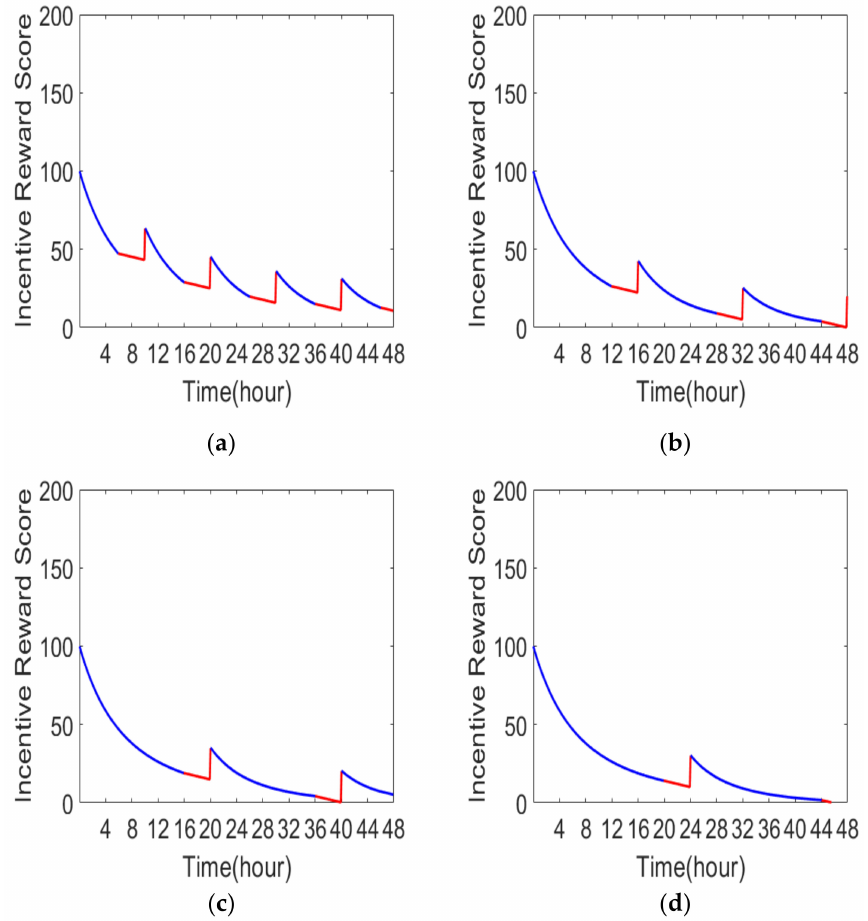
Figure 8. Comparison of incentive score with different negative collaboration time(red: positive, blue: negative): ( a ) Edge devices that passively collaborate for 6 h; ( b ) Edge devices that passively collaborate for 12 h; ( c ) Edge devices that passively collaborate for 16 h; ( d ) Edge devices that passively collaborate for 20